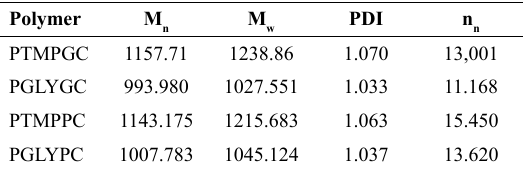
Figure 6. MALDI-TOF-MS spectra for (a) PTMPGC, (b) PGLYGC, (c) PTMPPC and (d) PGLYPC with their fragmentations, polymer series, leaving groups and fragmentation mechanism Table 3. Mn, Mw, PDI and nn of polymers by MALDI-TOF